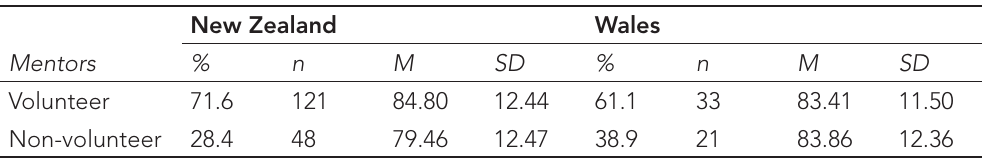
Table 4. Mentor volunteers and non-volunteers New Zealand